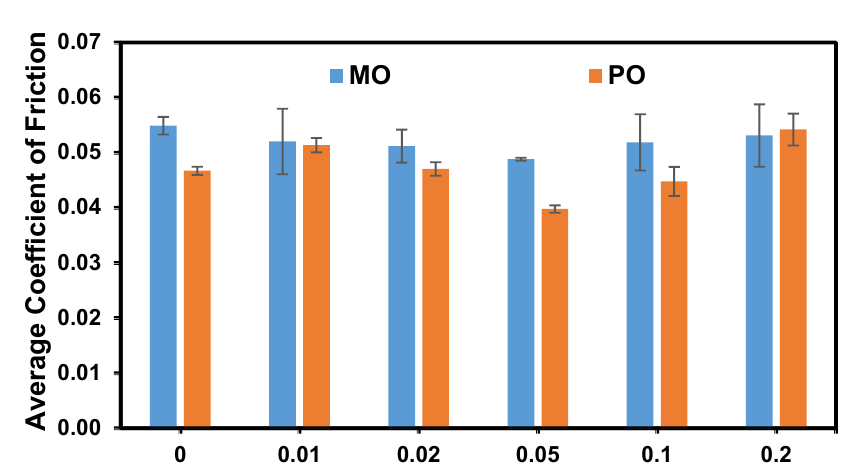
Figure 4. The COF results achieved using both PO and MO oils with different GNPs concentrations (0 to 0.2 wt %).